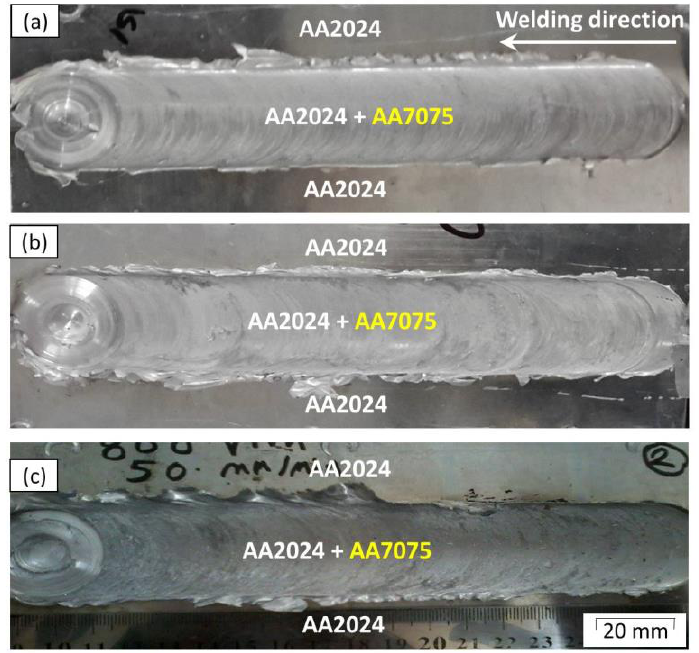
Figure 4. T-butt joint appearance of friction stir welded AA2024 and AA7075 at 50 mm/min welding travel speed and different rotational speeds ( a ) 400 rpm, ( b ) 600 rpm, and ( c ) 800 rpm.